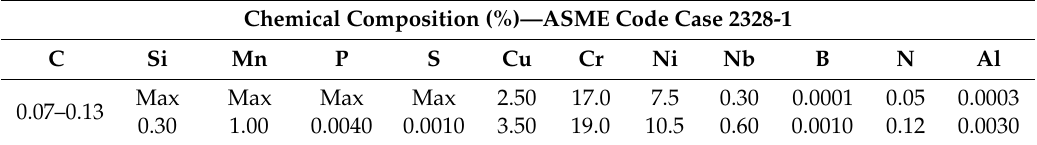
Table 1. Chemical composition of Super 304H steel.